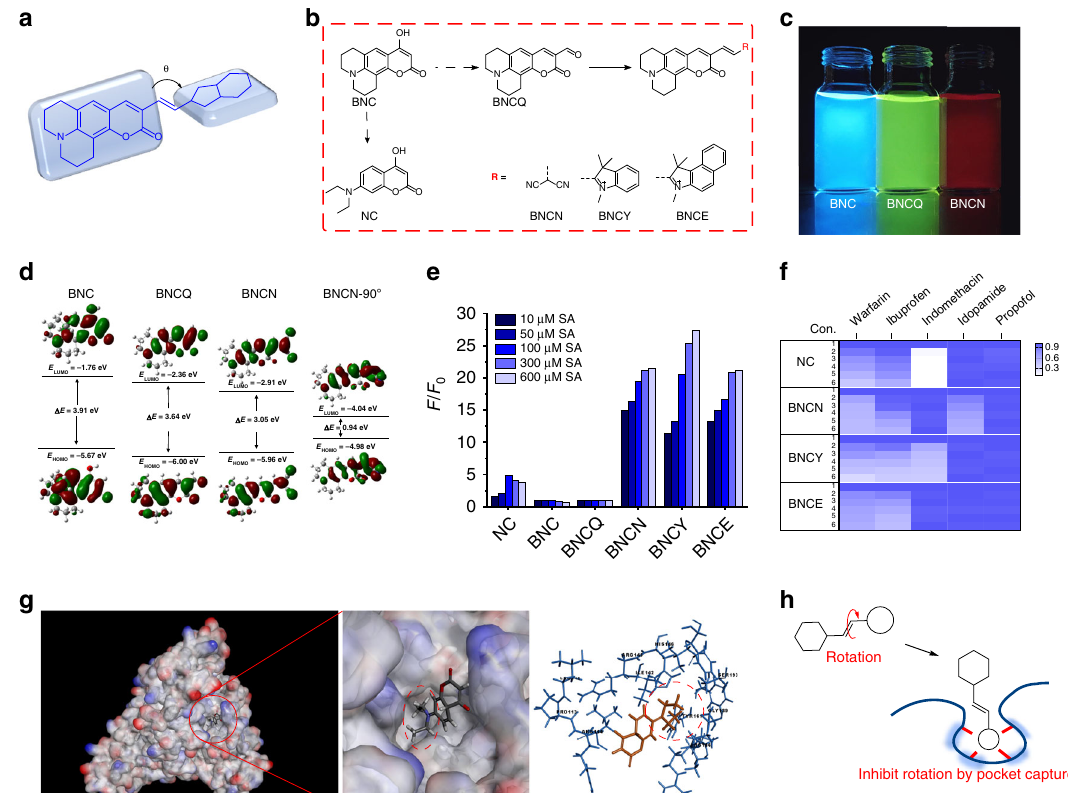
Fig. 2 Elucidation of the albumin- fl uorophore binding mechanism. a The illustration of “ transplanted ” TICT dyes. b Chemical structures of NC, BNC, BNCQ, BNCN, BNCY, and BNCE. c Fluorescence of BNC, BNCQ, and BNCN in PBS solution (pH 7.4, 10 mM) under a 365 nm excitation. d DFT optimized molecular orbital plots (LUMO and HOMO) of BNC, BNCQ, BNCN, and BNCN-90°. e Concentration-dependent fl uorescence changes of NC, BNC, BNCQ, BNCN, BNCY, and BNCE with the addition of albumin (10 − 600 µ M) in PBS solution (pH 7.4, 10 mM) at room temperature. f Fold changes (from white to blue) for NC, BNCN, BNCY, and BNCE in 10 µ M albumin with different concentration of inhibitors. Con. indicates the concentration of the inhibitors. 1, 0 µ M; 2, 50 µ M; 3, 100 µ M; 4, 150 µ M; 5, 200 µ M; 6, 250 µ M. g The conformation of albumin and NC. h The scheme of “ pocket capture ” for albumin to TICT dyes. F 0 and F are the fl uorescence intensity at the maximum emission wavelength without and with the presence of analyte, respectively. Source data for Fig. 2e, f are provided as a Source Data fi le.